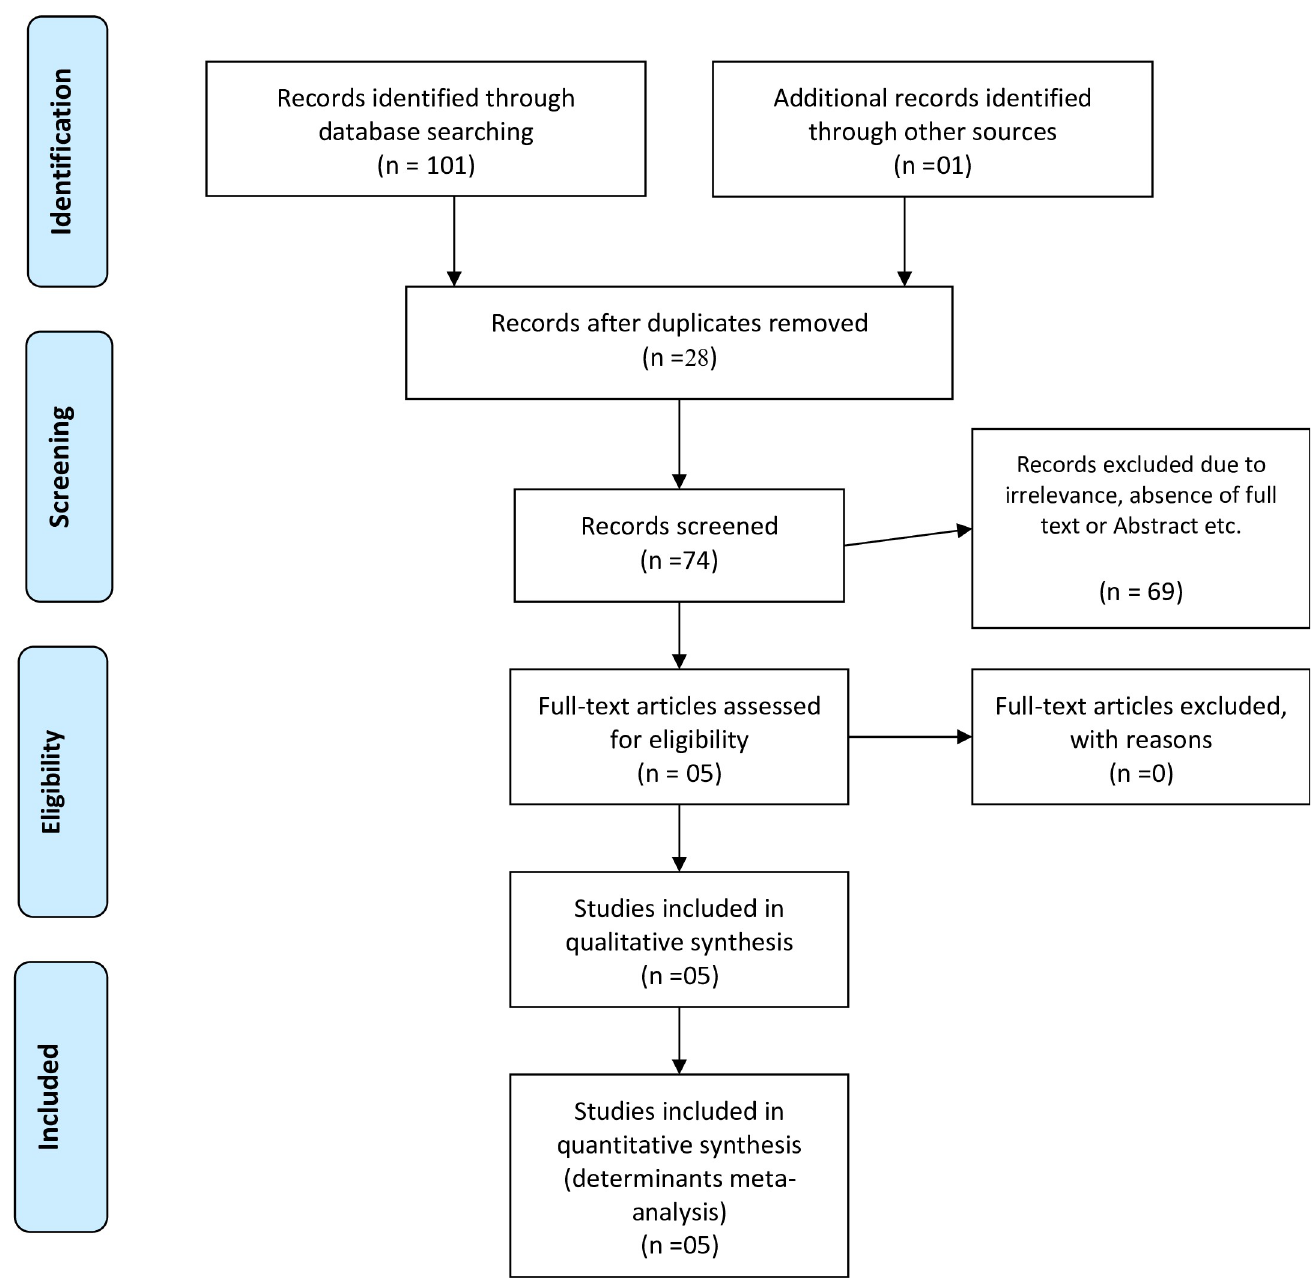
Fig 3. PRISMA flow chart of study selection for systematic review and meta-analysis of determinants of neonatal near miss in Ethiopia.